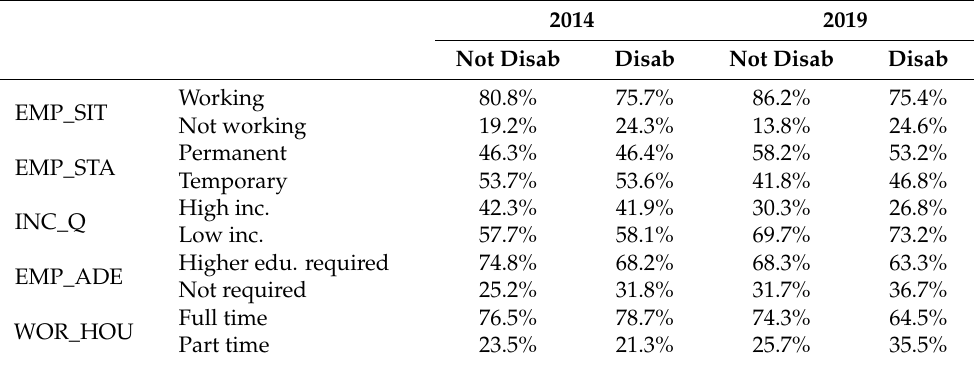
Table 1. Success of labor market insertion of graduates in Spain,